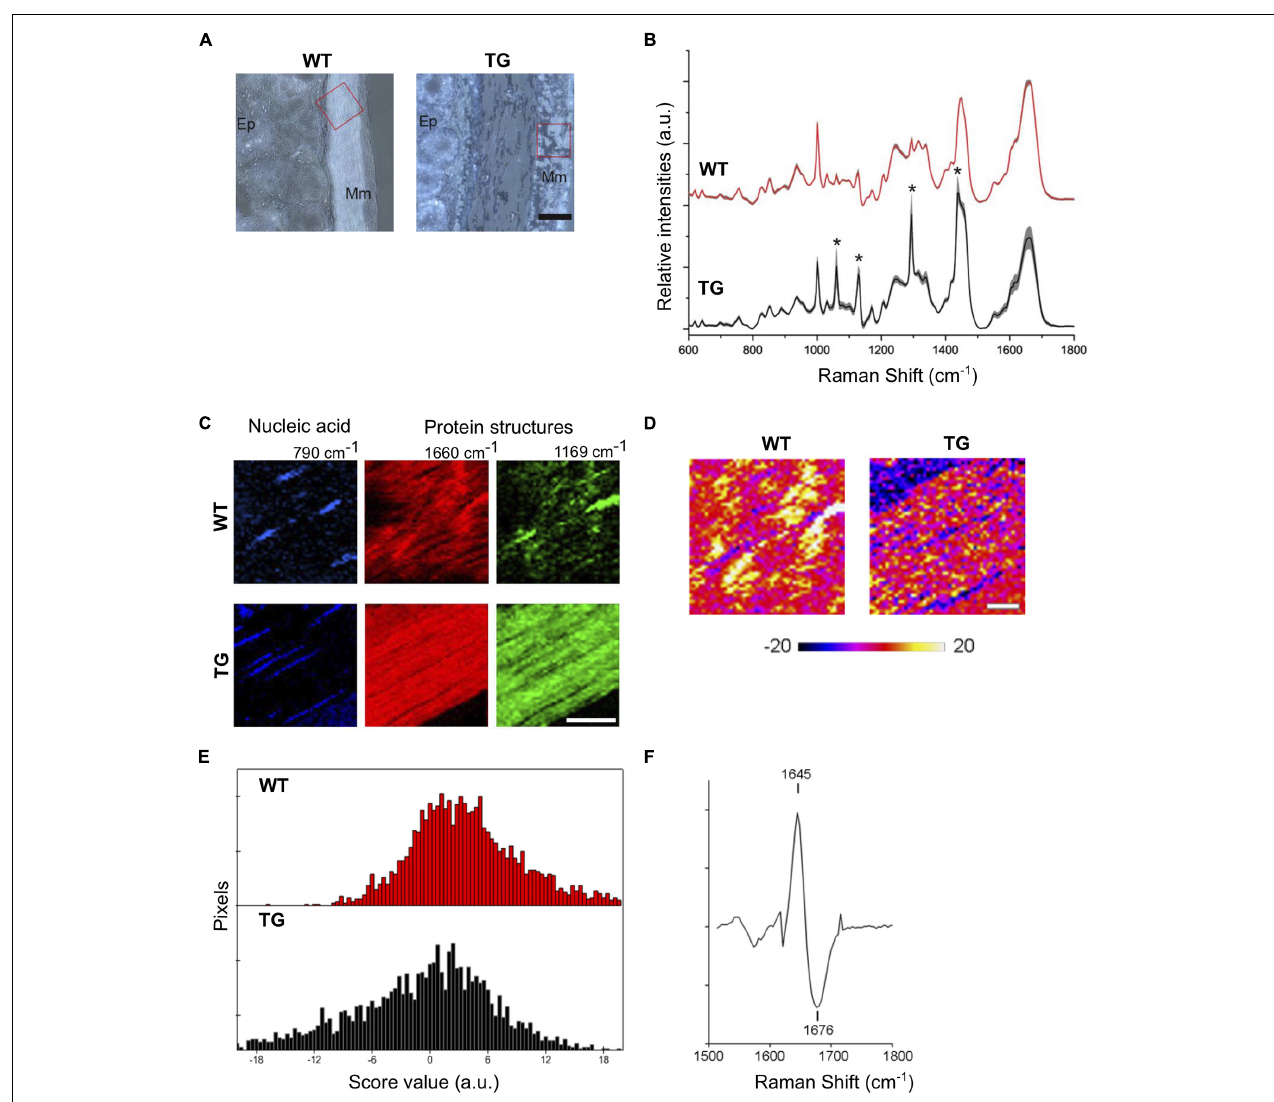
FIGURE 3 | Label-free imaging of TG rat colons. (A) Bright field images of WT and TG rat colon tissues (2M). Scale bar equals 50 µ m. Ep., epithelium; Mm, muscularis mucosae. Red box marks scanned areas using Raman microspectroscopy. (B) Mean Raman spectra of Raman images ( n = 3). Grey shades indicate standard deviations. Asterisk indicates Raman peaks referring to paraffin. (C) Representative Raman images based on the sum intensities for specific peaks assigned to nucleic acids (790 cm − 1 ) and proteins (1,660 and 1,169 cm − 1 ) of WT and TG rat colon tissues. TG rat colons lack muscular striation pattern visible via amide I peak at 1,660 cm − 1 in WT tissues. TG tissues show increased intensities for 1,169 cm − 1 throughout the image. Scale bar equals 20 µ m. (D) PCA of Raman images for amide I region indicate shifts in protein structure for TG rat tissues. (E) Representative images of WT and TG rat colon tissues of amide I region. Distribution of PC-2 score values showing range of positive values for WT and negative scores for TG tissues. (F) PC loading spectrum indicating a shift of amide I toward 1,676 cm − 1 for pixels with negative score